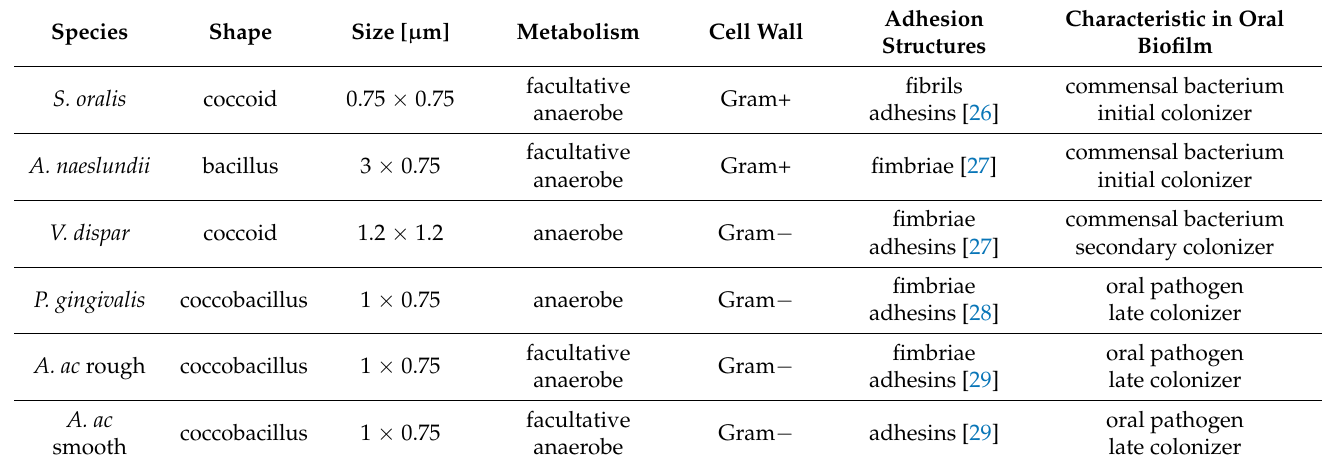
Table 1. Characteristics of bacterial strains analyzed in the